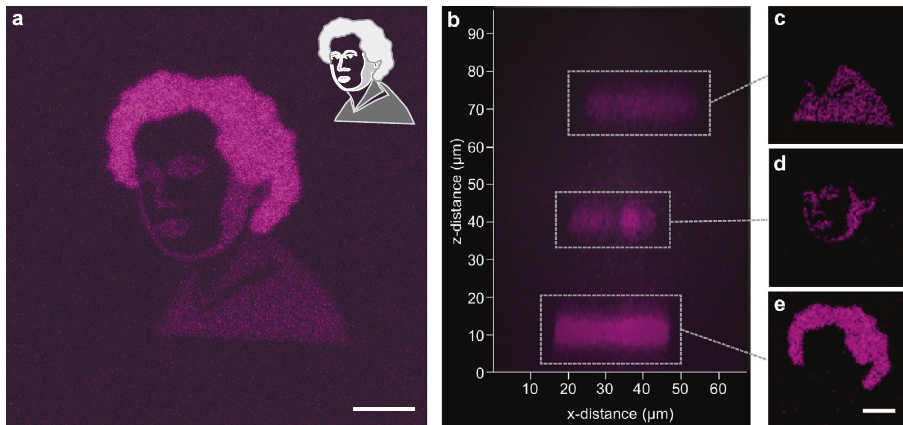
Fig. 7 Two-photon induced 3D arbitrary patterns in a photoinstructive TPA- tris NTA matrix. a The portrait of Maria Goeppert-Mayer was printed by two-photon excitation (800 nm, 3.1 mW, 12 s; presence of 50 µ M RB) in three different z layers. Structures were visualized by assembly of AF647-POI followed by CLSM. The custom-made ROI design for laser activation is shown on the top right. b Orthogonal cross sections (x/z plane) of the two-photon patterned ROIs imaged by CLSM. Images displayed a sharp, spatially localized activation of TPA- tris NTA at µ m-scale within multiple z layers and showed a con fi ned immobilization of AF647-POI in z direction. c – e CLSM images show the respective focal plane (x,y) indicated by gray dashed lines. Scale bars: 10 µ